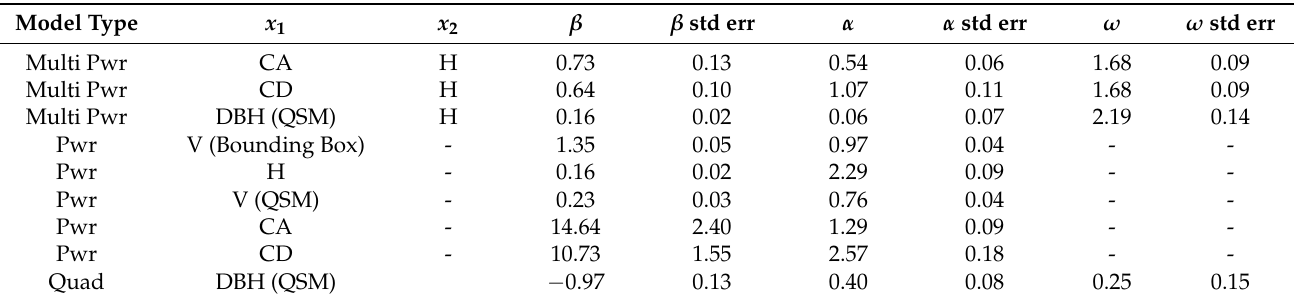
Table 4. Model coefficients and their standard errors for models in Table 3. AGB = above ground biomass, Multi